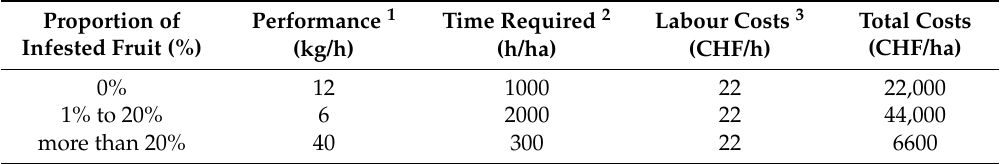
Table 6. Harvesting costs depending on the extent of fruit infestation by Drosophila suzukii in sweet cherry production in Switzerland.